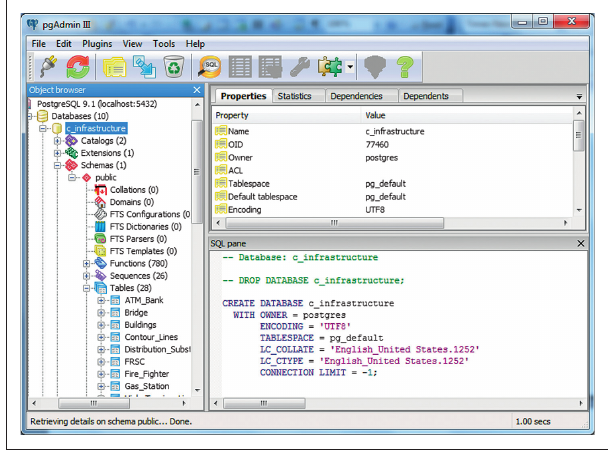
FIGURE 7: PgAdmin interface of